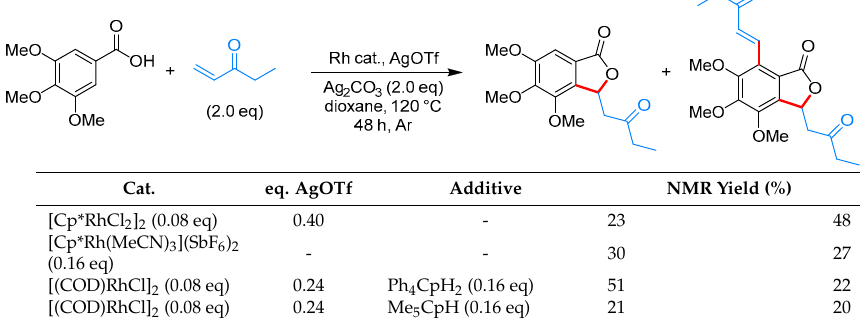
Table 1. Catalyst and additive effects on chemoselectivity of the Rh-catalyzed annulative coupling of benzoic acids and alkenes.